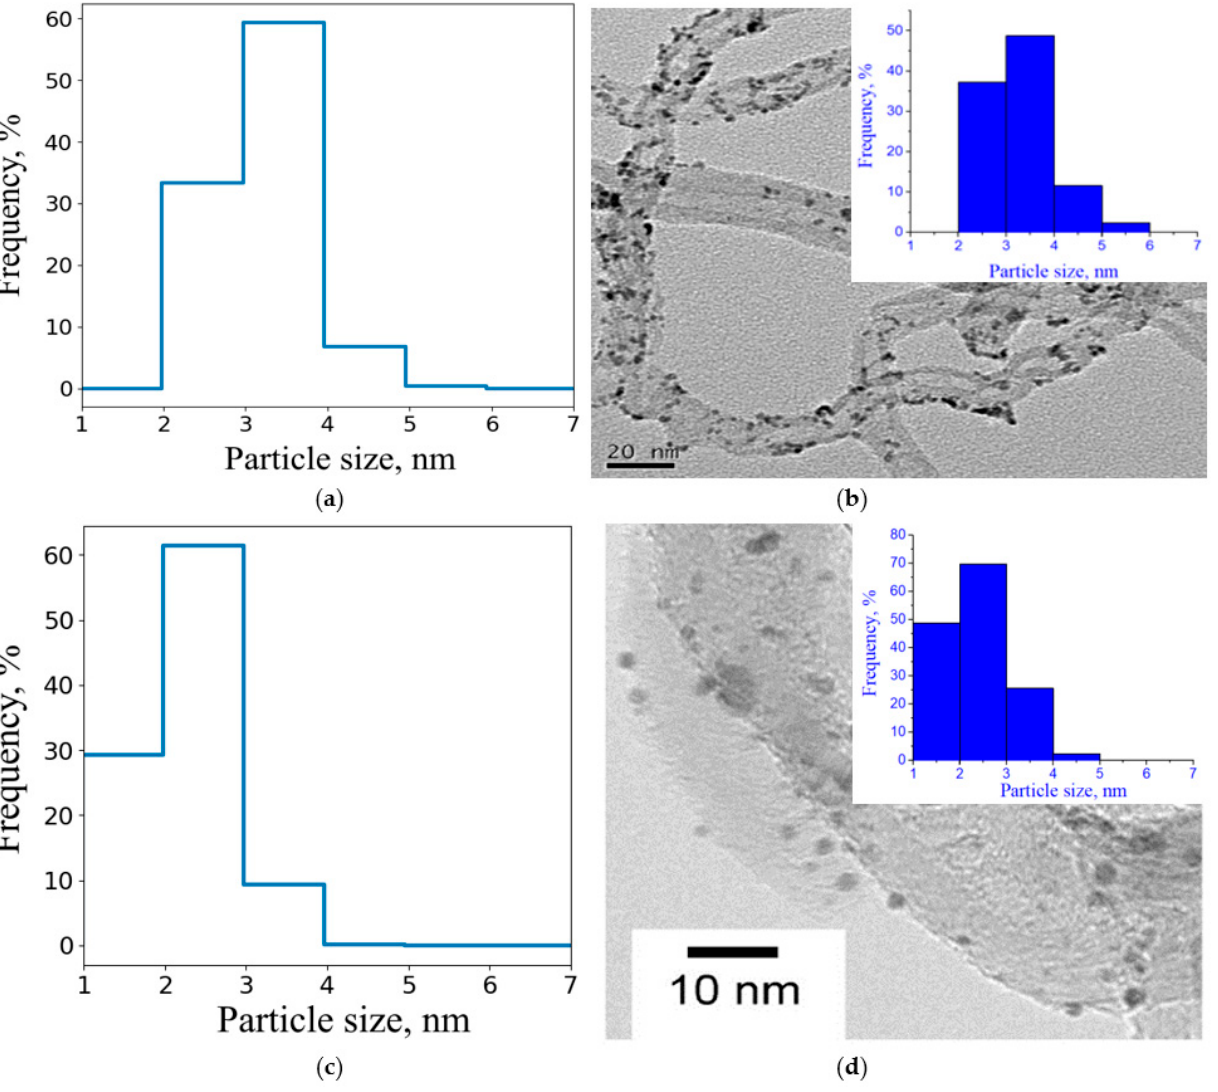
Figure 2. Simulated size distribution of platinum nanoparticles ( a , c ) and distribution obtained from the TEM images of the Pt/CNT samples ( b , d ) from [28] and [31], respectively. Calculations were also carried out using characteristics of a Pt/CNT electrocatalyst sample experimentally obtained in the laboratory. The CCL parameters include the tube diameter (d CNT = 50 nm), CNT length (L CNT = 100 μ m), CNT array density (N CNT = 2 × 10 10 tubes cm − 2 ), platinum loading (M Pt = 0.3 mg/cm 2 , or 20 wt.%), minimum distance between particles (R c = 20 nm), and minimum particle size (d n = 4 nm). The simulation gave the EASA value of 25 m 2 /g and average particle size of 5.2 nm. The resulting particle size distribution is shown in Figure 3a.